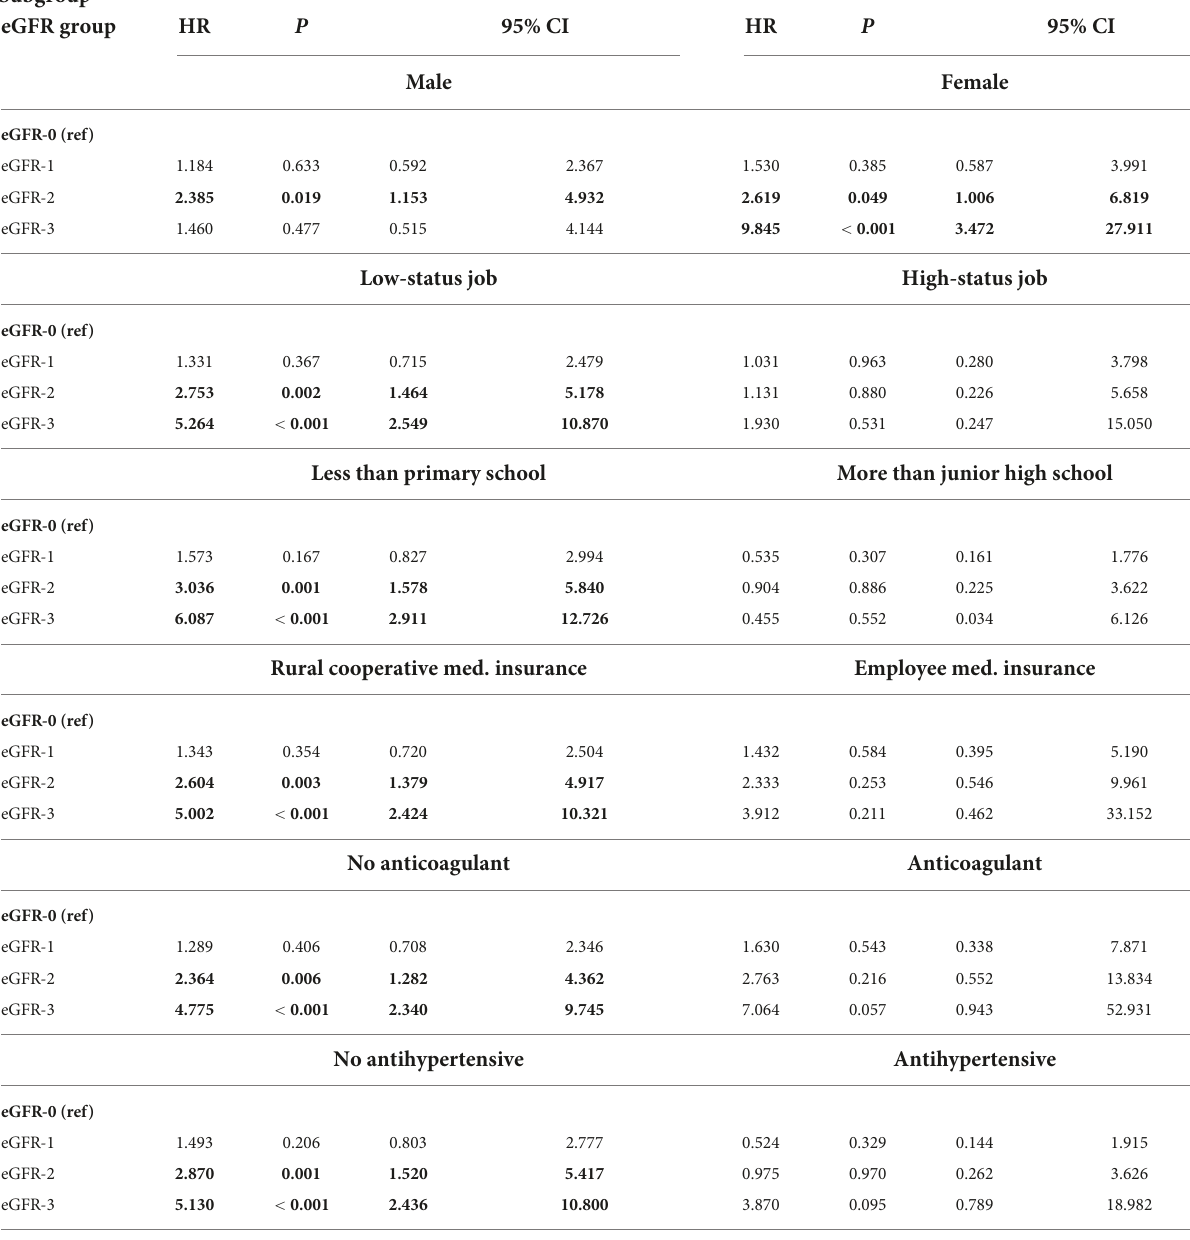
TABLE 3 Subgroup analyses of the association of all-cause mortality with eGFR in patients admitted for atrial fibrillation*,**. Subgroup